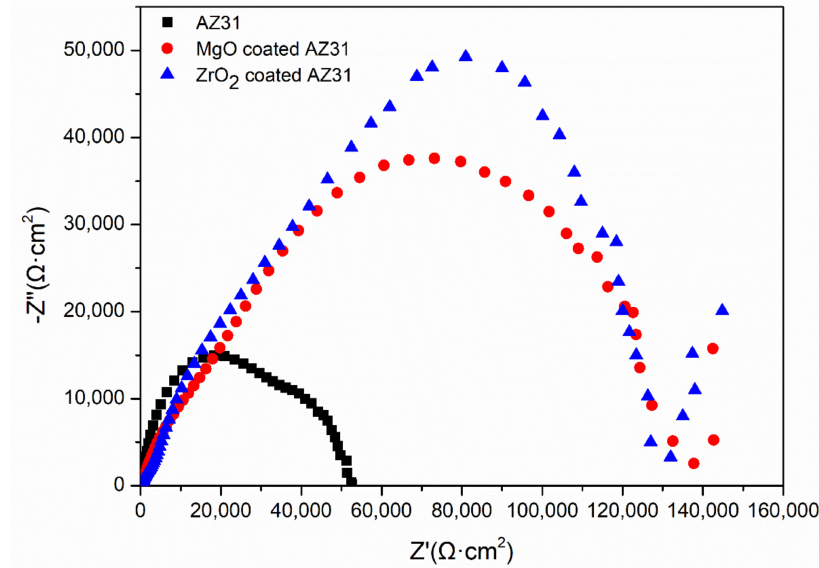
Figure 6. Nyquist curve. For numbers with five or more digits, the digits are grouped with commas placed between groups of three counting to the left of the decimal point. For example, change “160000” to